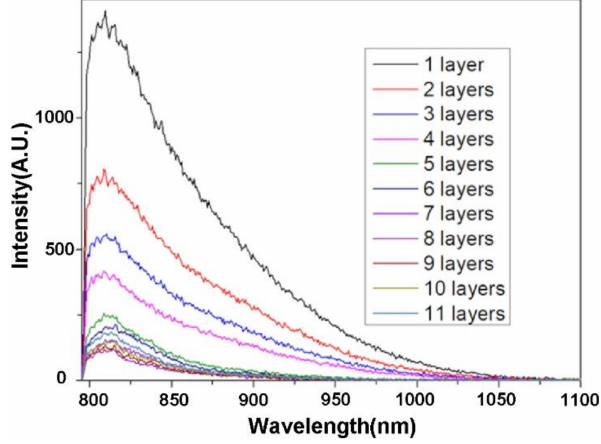
Figure 6. The intensity of the NIR fluorescence of the sample detected was suppressed after covered by various layers of bacon